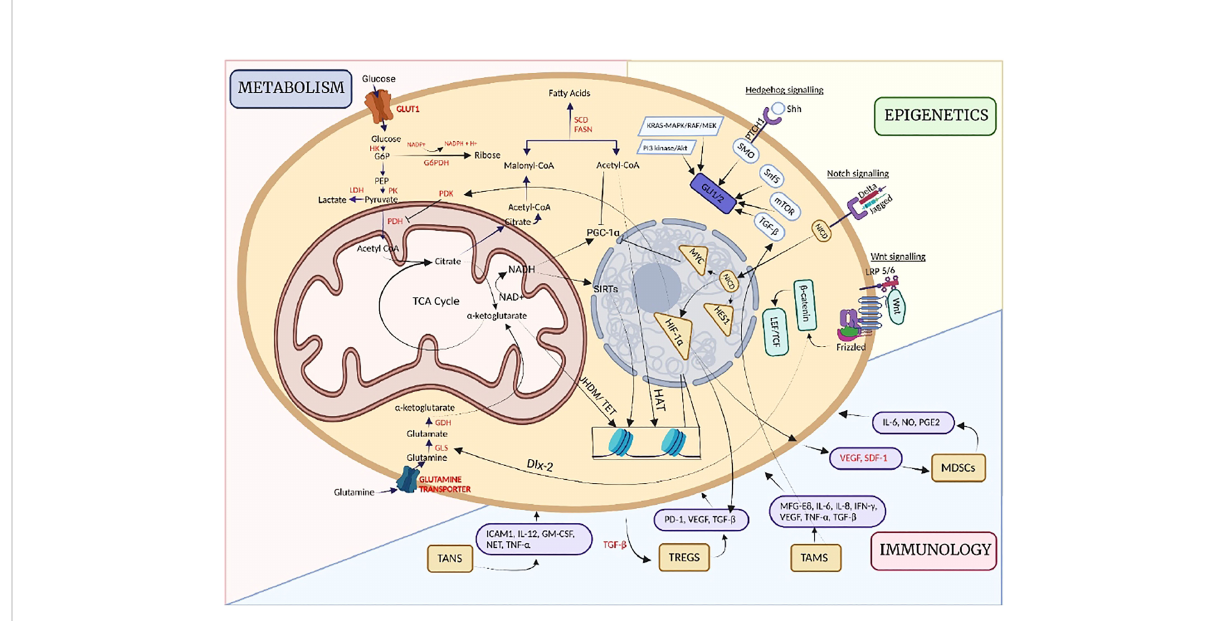
FIGURE 3 Pictorial representation of the different functional domains of Cancer Stem Cells. Epigenetic mechanisms have a profound in fl uence on regulating the activities of key metabolic enzymes. Several of the enzymatic reactions, in turn, produce metabolites and onco-metabolites that in turn orchestrate key signaling pathways. TET ( Ten Eleven translocases) are one such mediator. Epigenetic mechanisms in turn also regulate mitogenic signals and alter the way cell interacts with their surroundings.